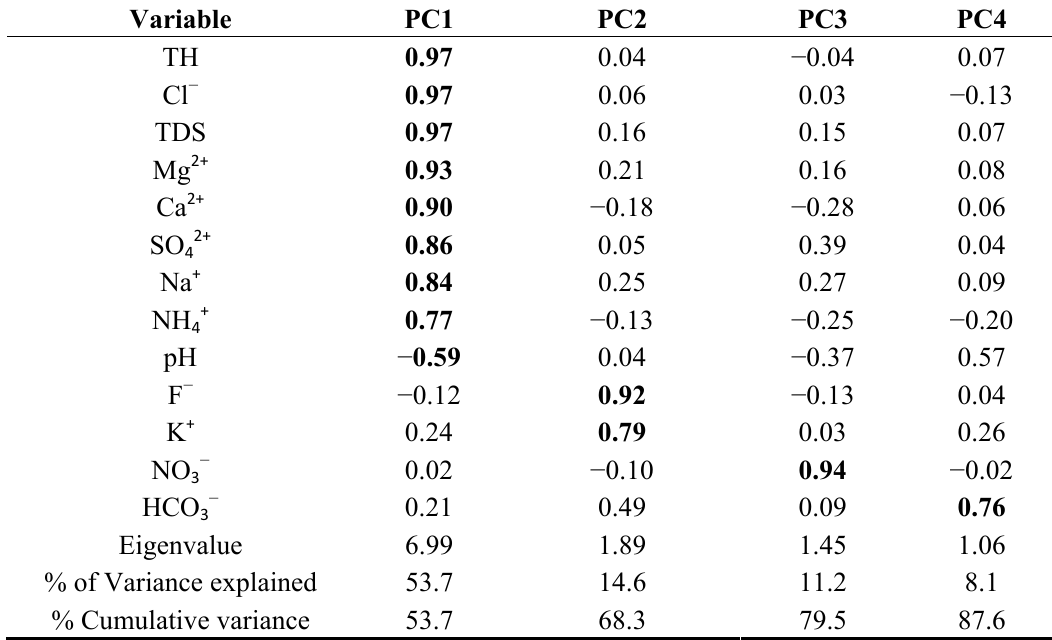
Table 3. Loadings of variables on 4 Principal Components (PCs) of water quality